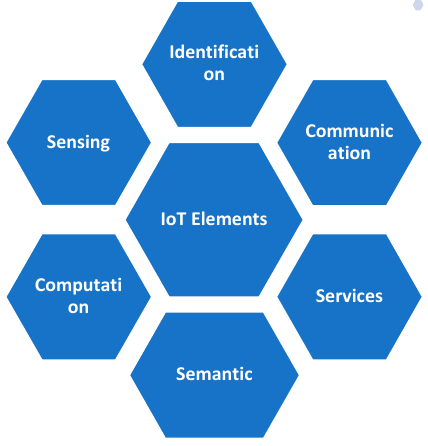
Figure 5. Elements of the IoT.